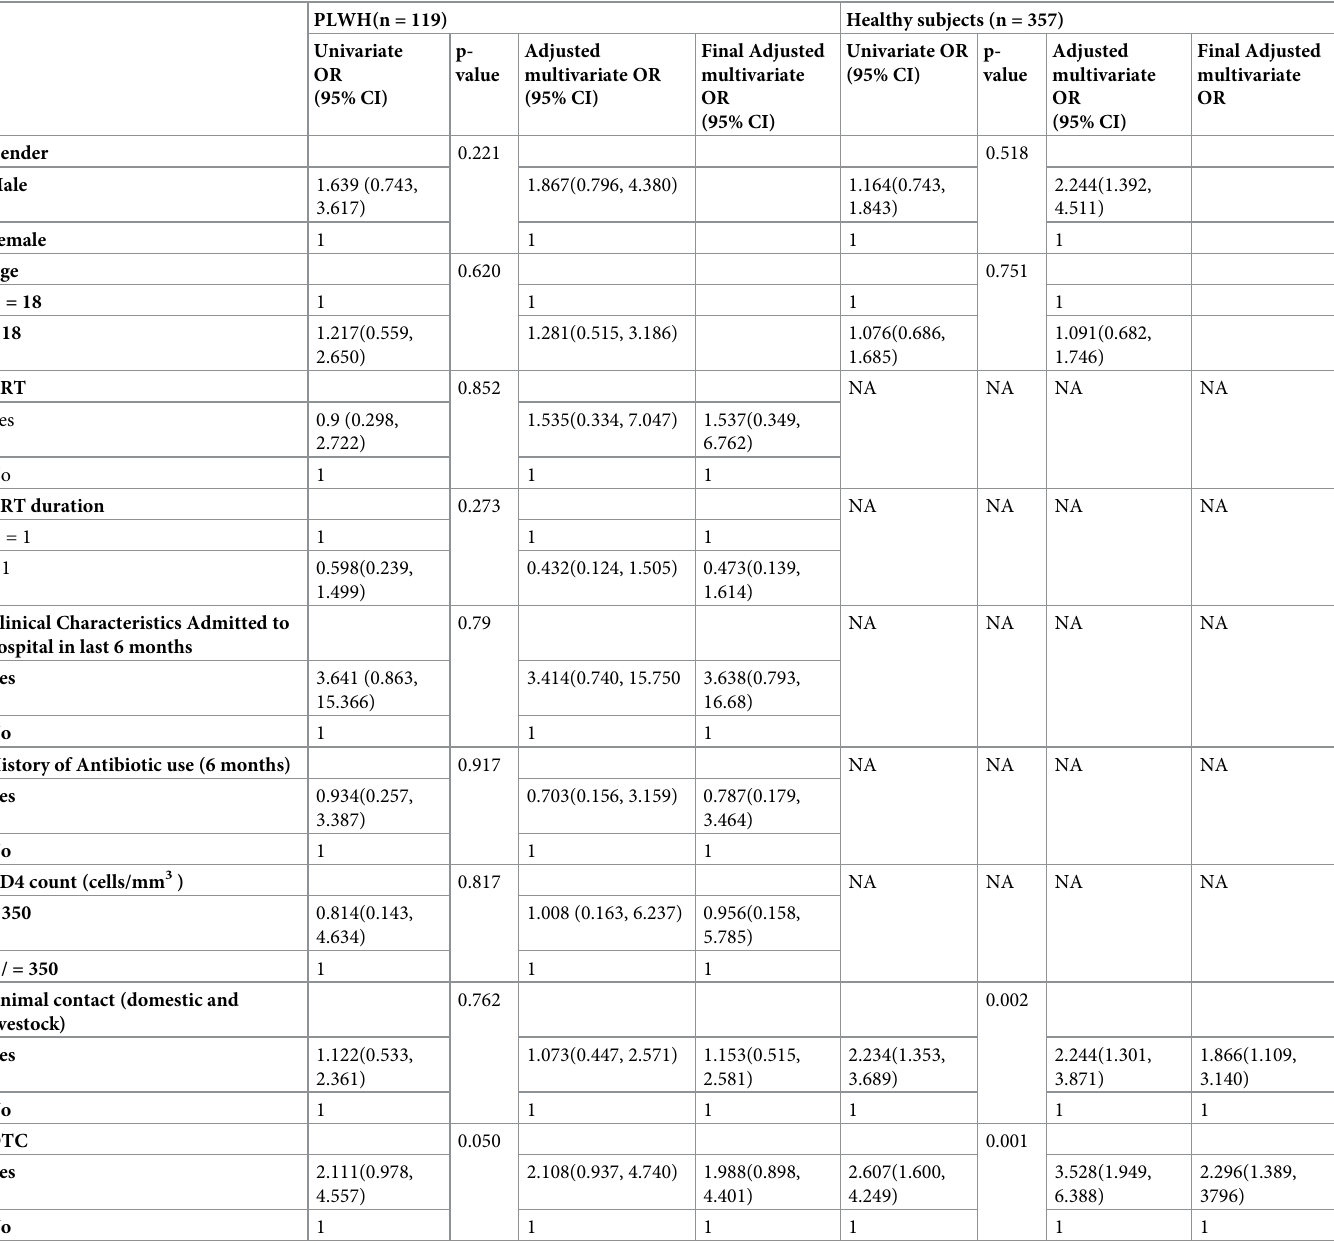
Table 2. Univariate and multivariate analysis of factors associated with ESBL-E